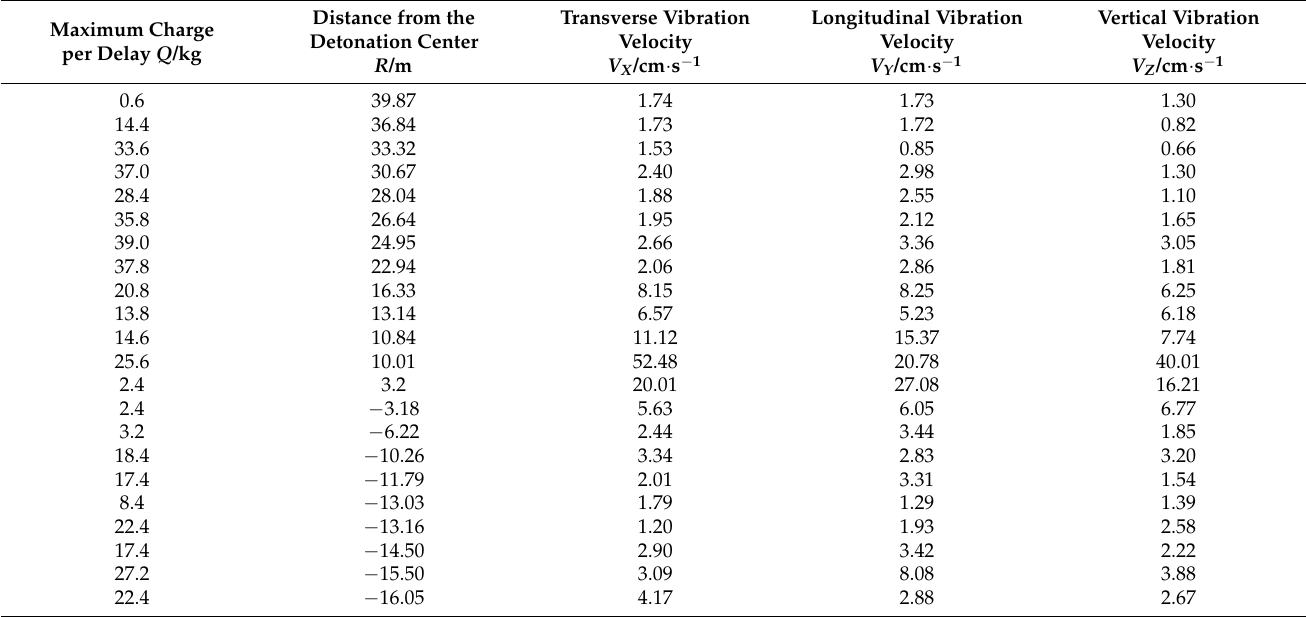
Table 2. Blasting vibration monitoring data.